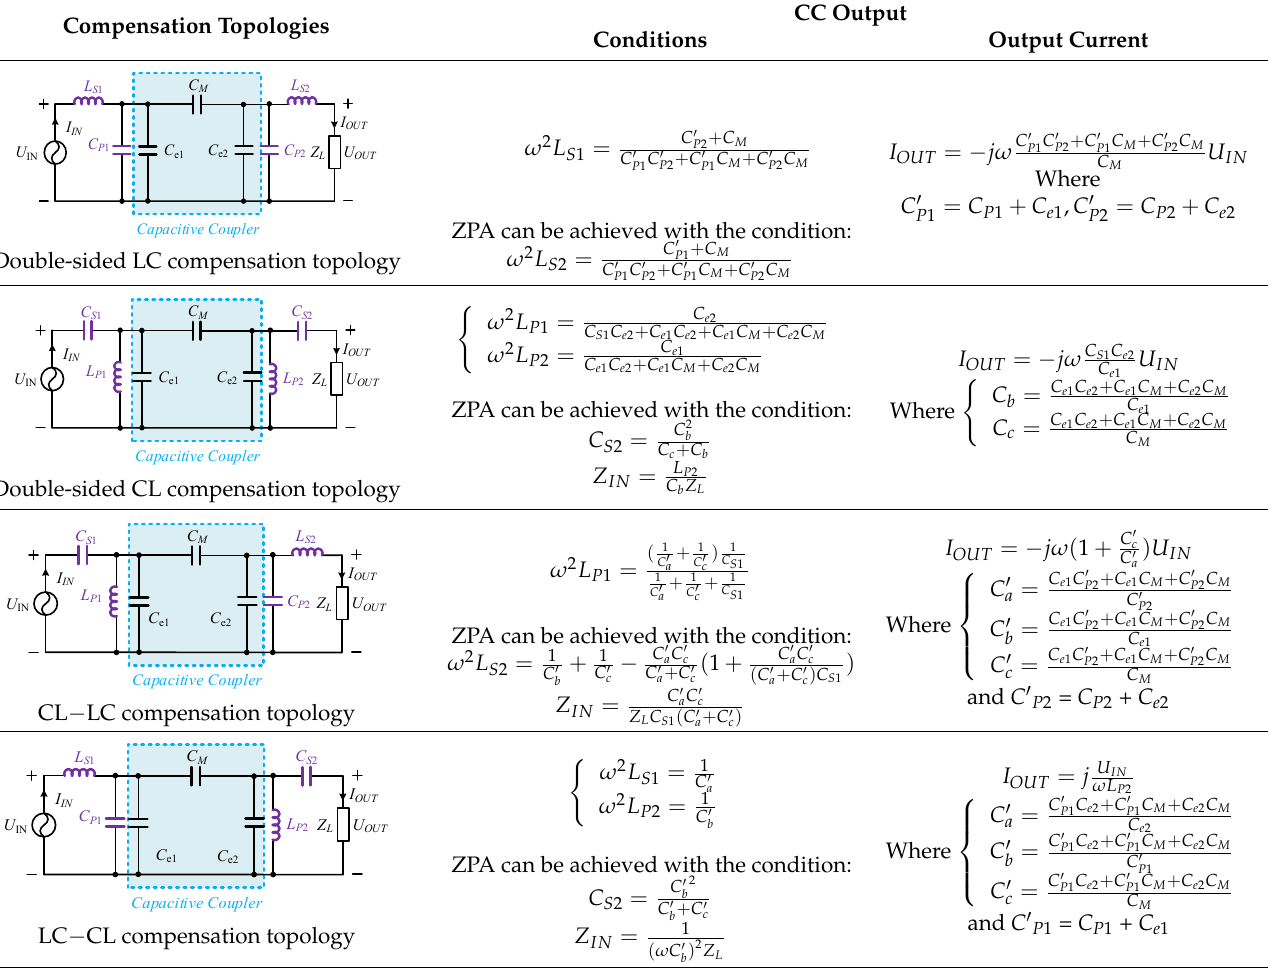
Table 2. Comparison of SP-based compensation topologies to achieve CC output.